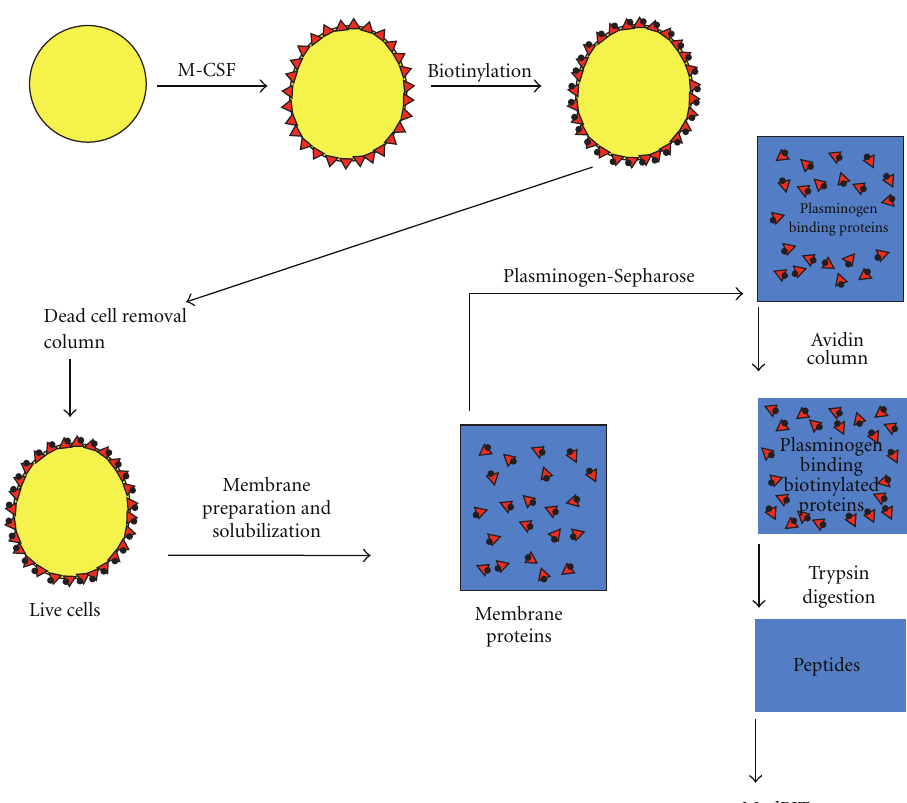
Figure 1: Isolation of plasminogen receptors. Monocyte (Hoxa9-ER4) progenitor cells were di ff erentiated with macrophage colony stimulating factor (M-CSF), which induces plasminogen receptors ( (cid:2) ) on these cells. Then intact cells were biotinylated ( • ) and passed over a dead cell removal column. Live cells were then lysed and membrane fractions prepared and passed over a plasminogen-Sepharose a ffi nity column and specifically eluted. Biotinylated plasminogen receptors ( (cid:2) • ) were then bound to an avidin column and digested with trypsin. This figure was originally published in